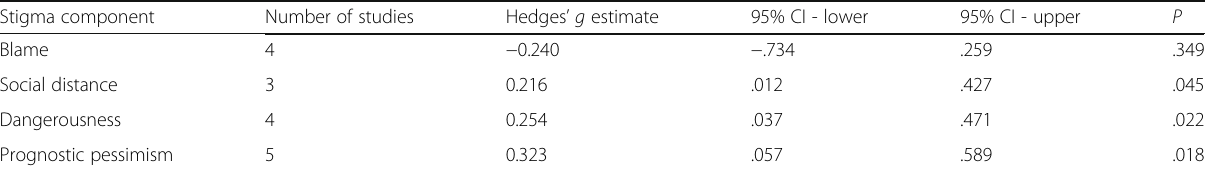
Table 2 Summary of meta-analytic findings from experimental studies Stigma